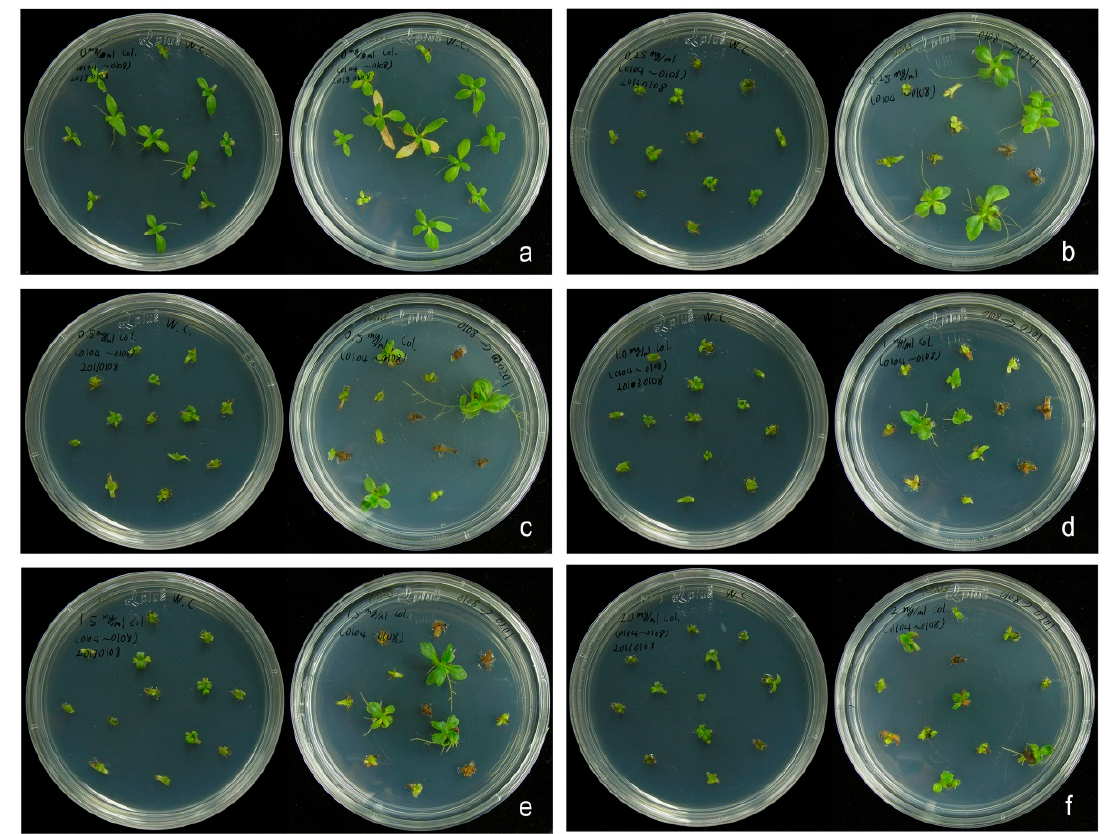
Figure 2. Typical growth patterns of newly regenerated apical shoots which were cultured on MS medium supplemented with different concentrations of colchicine for 4 days and then transferred onto MS medium without adding colchicine for one month. ( a ) No colchicine treatment; ( b ) 0.25 g/L colchicine; ( c ) 0.5 g/L colchicine; ( d ) 1 g/L colchicine; ( e ) 1.5 g/L colchicine; ( f ) 2 g/L colchicine.